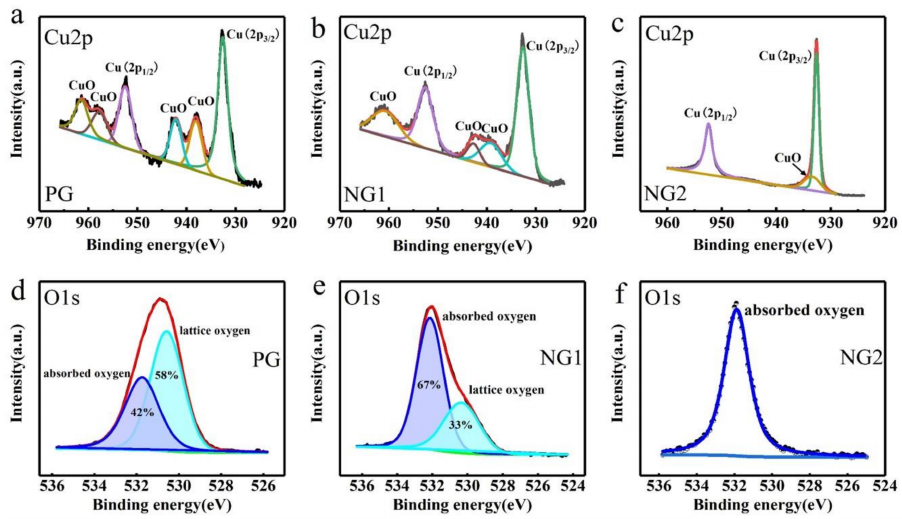
Figure 5. ( a ) XPS core-level Cu 2 p spectra of PG-, ( b ) NG1-, and ( c ) NG2-coated Cu after 90 days of exposure. ( d ) XPS core-level O 1s spectra of PG-, ( e ) NG1-, and ( f ) NG2-coated Cu after 90 days of exposure.